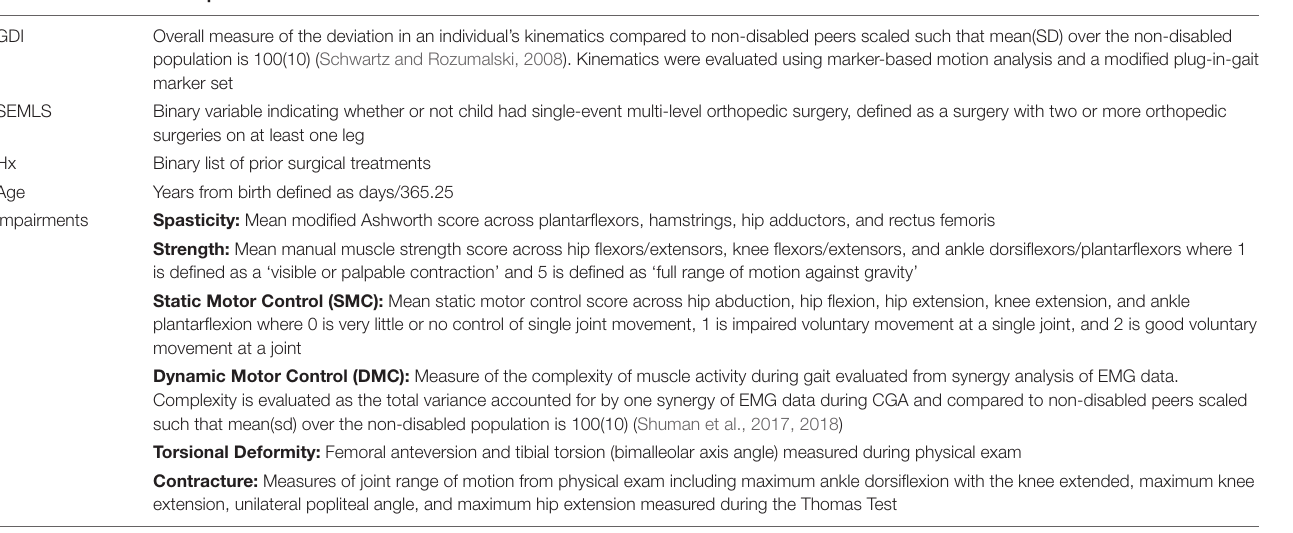
TABLE 1 | Variable